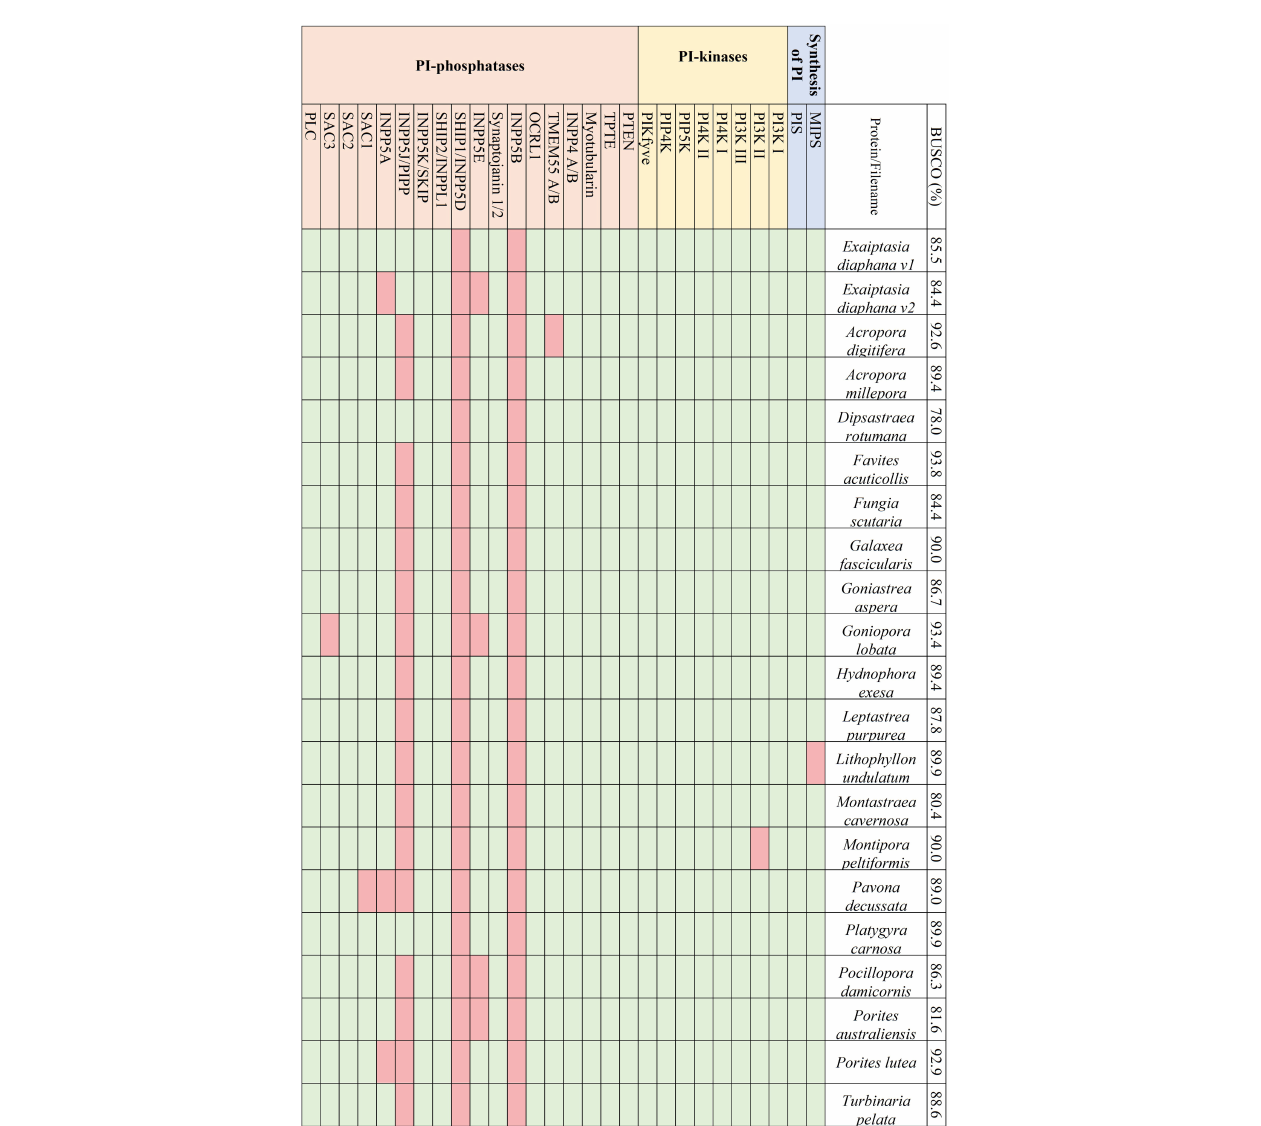
FIGURE2 The presence and absence of the proteins constituting the PI pathway across the 21 selected symbiotic anthozoan assemblies and the respective BUSCO scores.